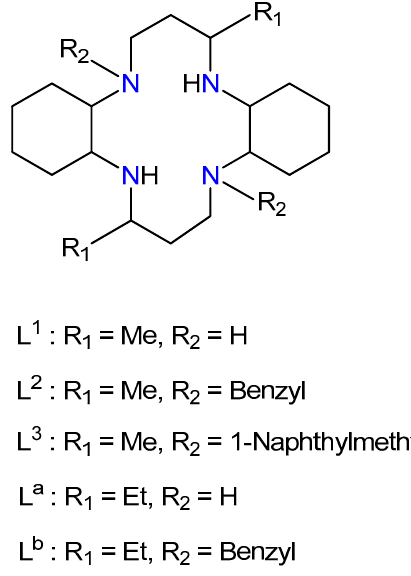
Scheme 1. Structures of various macrocyclic ligands.